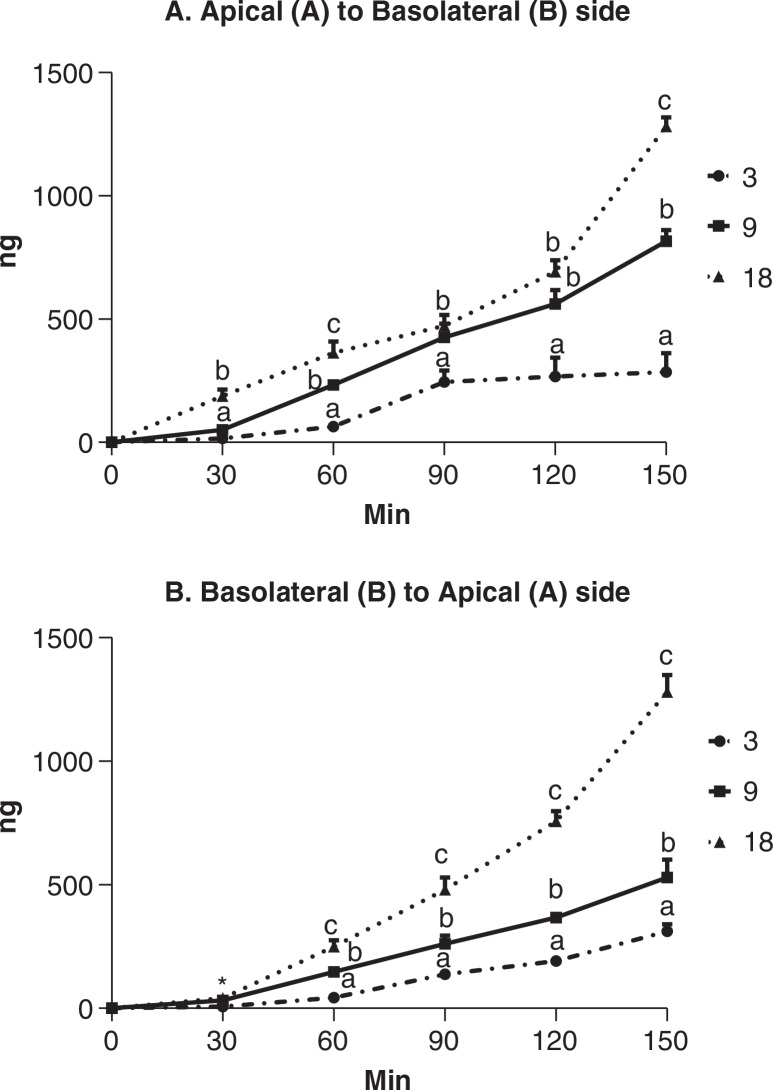
The transport of quercitrin by Caco-2 cells cultured in a Millicell (transwell) culturing system for 21 days, (A) quercitrin at the concentration of 3, 9 or 18 μg/mL is added to the apical chamber and quantified in the basolateral chamber and (B) quercitrin of the same concentrations is added to the basolateral chamber and quantified in the apical chamber. Vehicle containing no quercitrin was also administered but the data were shown in the figure because quercitrin was not detected. Quercitrin is quantified using LC-MS in the collected culture media at 30, 60, 90, 120, and 150 min post administration. Values are expressed as mean ± SD (n = 3). abcMeans at the same time points without sharing the same letter significantly differ (P < 0.05), tested by variance analysis of repeated measurement, followed by Fisher’s least significant difference (LSD) test with Bonferroni adjustment for multi-comparison. *At 30 min, the concentration of the high and middle doses are larger than the low dose and those of the high and middle are not different. The effect of transport direction, time, and dose factors on quercitrin transport is significant (P < 0.0001).